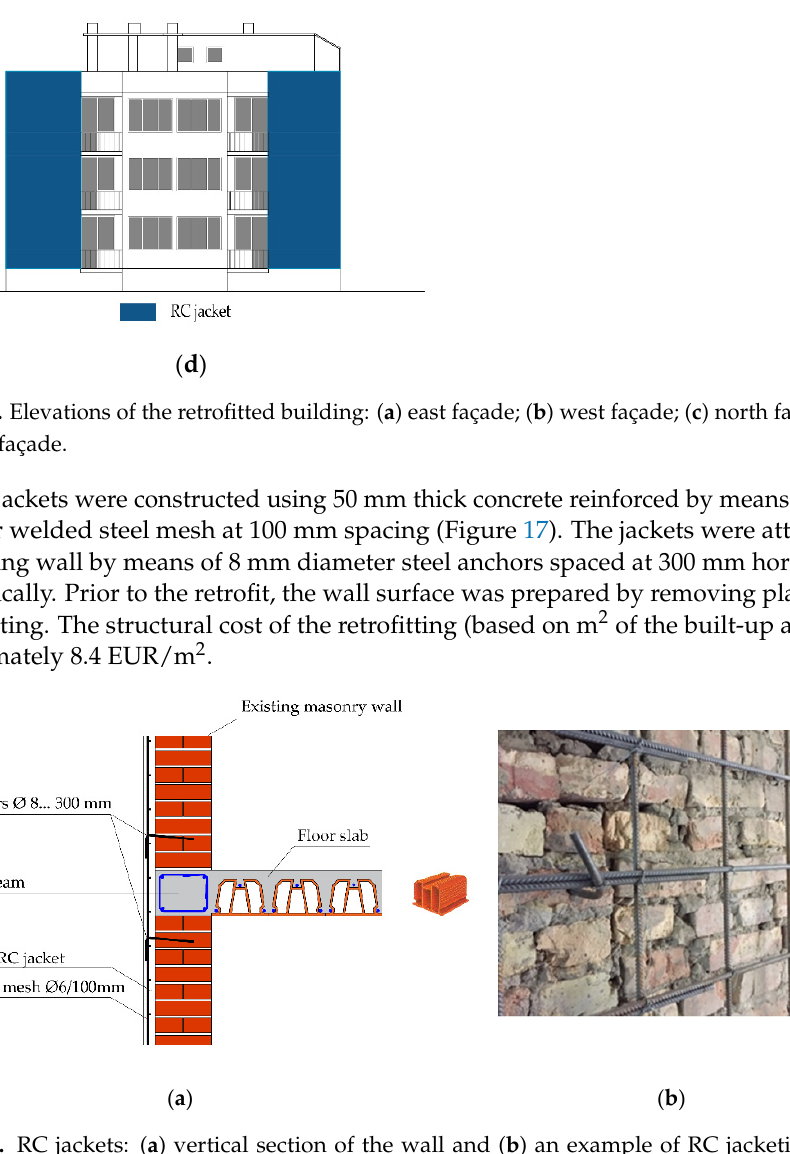
Figure 17. RC jackets: ( a ) vertical section of the wall and ( b ) an example of RC jacketing under con- struction [30]. construction